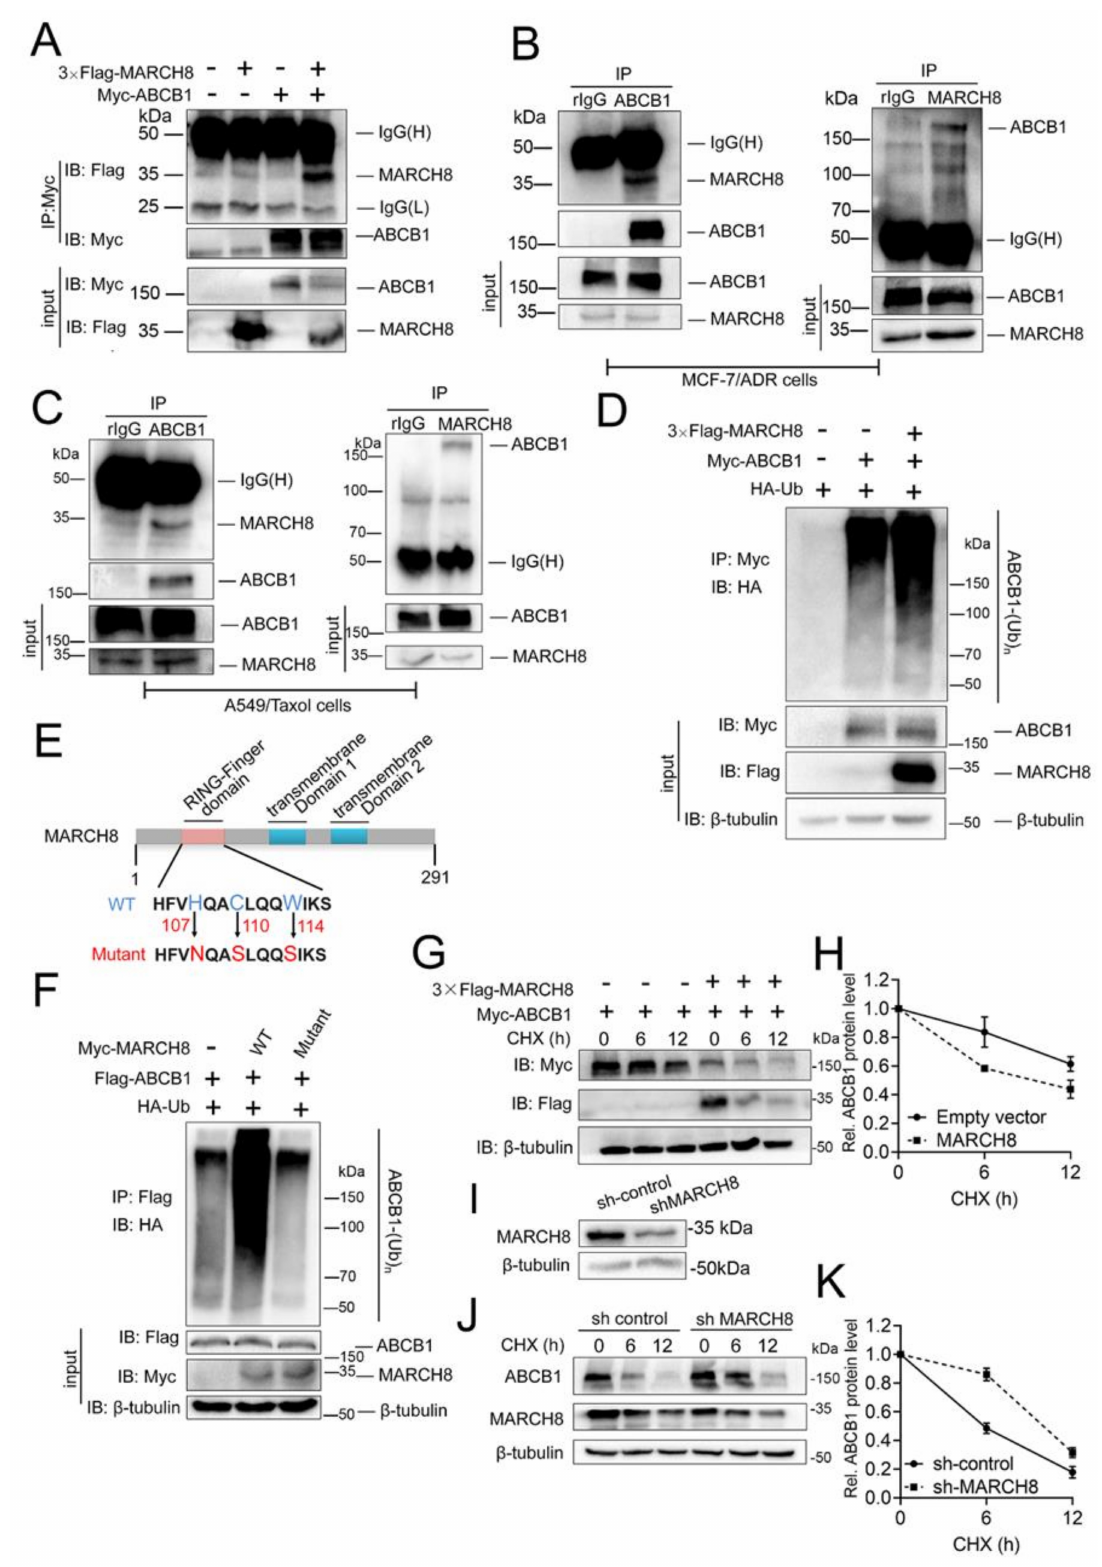
Figure 7. ABCB1 interacts with MARCH8 and positively regulates ABCB1 degradation. ( A ) The Myc-ABCB1 expres- sion plasmid was co-transfected with or without 3 Flag-MARCH8 into HEK293T cells. The ABCB1 protein was × co-immunoprecipitated (Co-IP) with the anti-Myc antibody, and the expression of MARCH8 and ABCB1 in the whole-cell lysate (WCL) was confirmed by immunoblotting (IB) with antibodies against Flag and Myc. ( B ) The endogenous